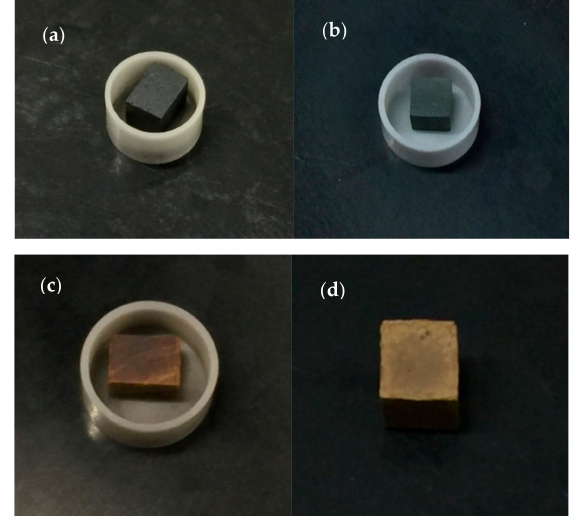
Figure 3. The specimens of the alloys JZ4 and JZ5 after isothermal oxidation at 800 and 1200 ◦ C; ( a ) and ( c ) alloy JZ4, ( b , d ) alloy JZ5; ( a , b ) 800 ◦ C, ( c , d ) 1200 ◦